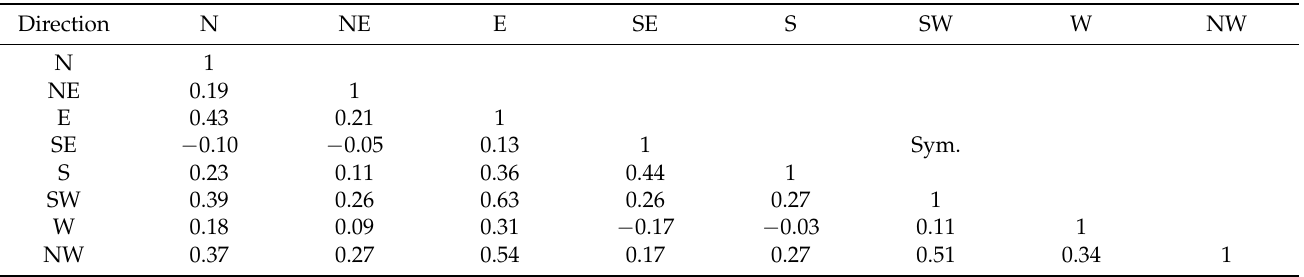
Table 1. Correlation coefficients of wind speeds between different wind directions in Jinan,